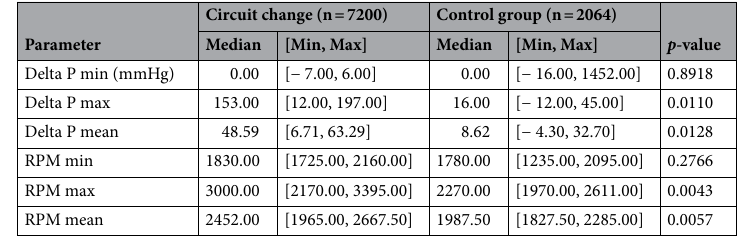
Table 3. Circuit parameter comparisons between circuit change and no-circuit change values. n = 9264 data time points. RPM revolutions per minute, Max maximum, Min minimum.